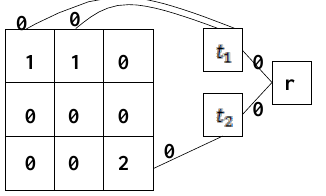
Figure 1. An example of addition of extra vertices , and r to the image graph for the construction of an MSF rooted on markers 1 and 2; non-marker pixels are denoted by ―0.‖